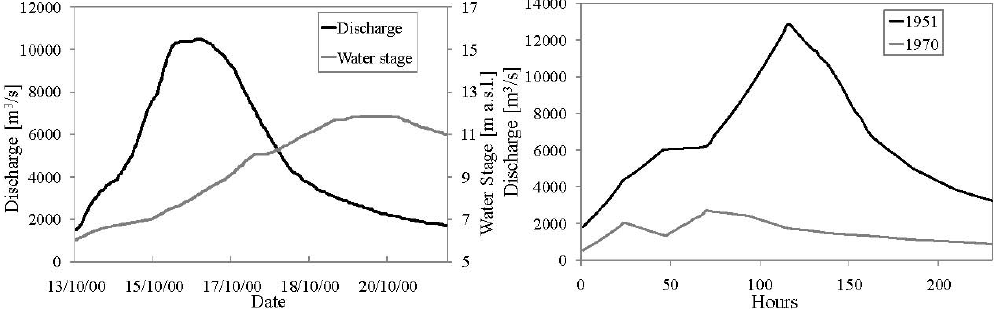
Fig. 2. Boundary conditions for the hydraulic modelling. October 2000 flood event: flow hydrograph and stage hydrograph observed at Piacenza and Pontelagoscuro, respectively (left panel). Examples of historical flow hydrographs observed at Piacenza and used for generating synthetic measurement campaigns (right panel).